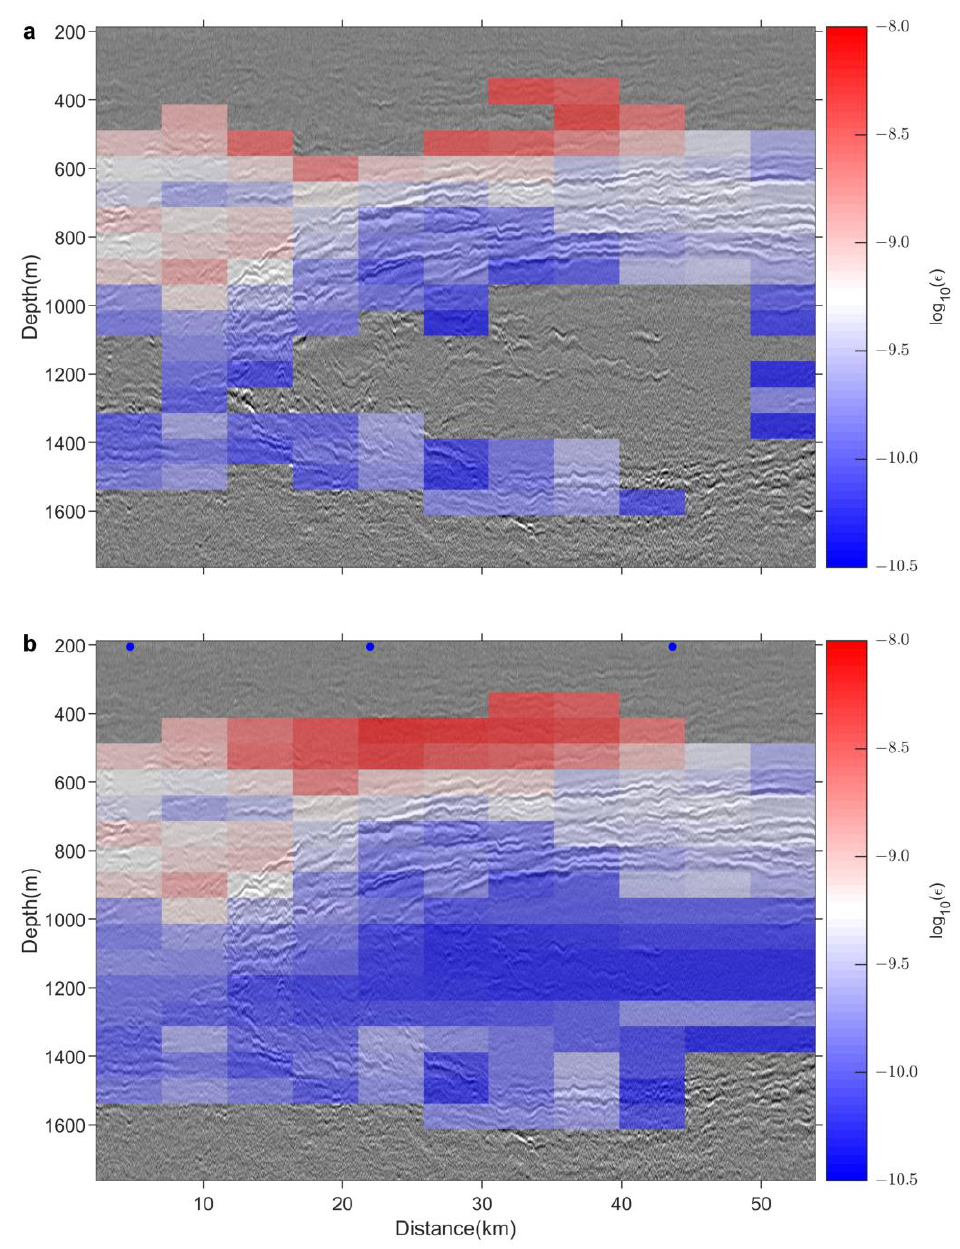
Figure 5. The seismically derived turbulent dissipation section. ( a ) The original 𝜀 distribution over- laying the seismic section; the grey area has no turbulent dissipation values due to the lack of seismic reflectors inside. ( b ) Similar to ( a ), but the 𝜀 is interpolated across the whole section. Blue dots rep- resent three CTD casts.